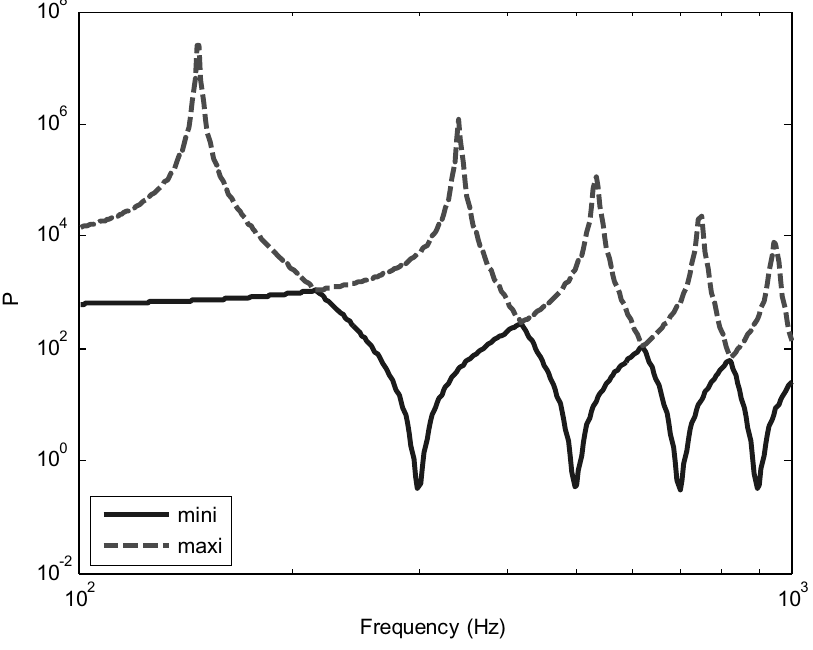
Fig. 15. Example 3, Trace of the input cross spectral density